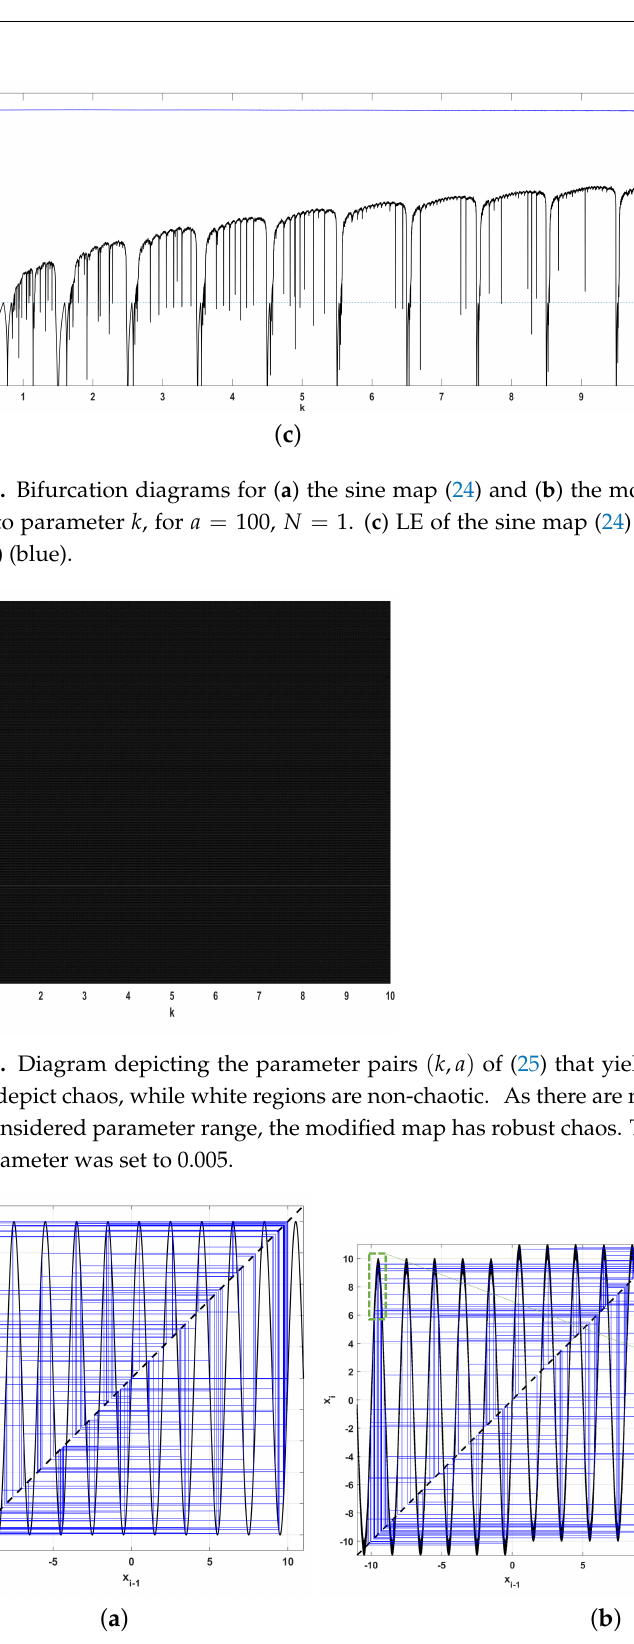
Figure 8. Cobweb diagrams for ( a ) the sine map (24) and ( b ) the modified sine map (25), for k = 10, a = 100, N =